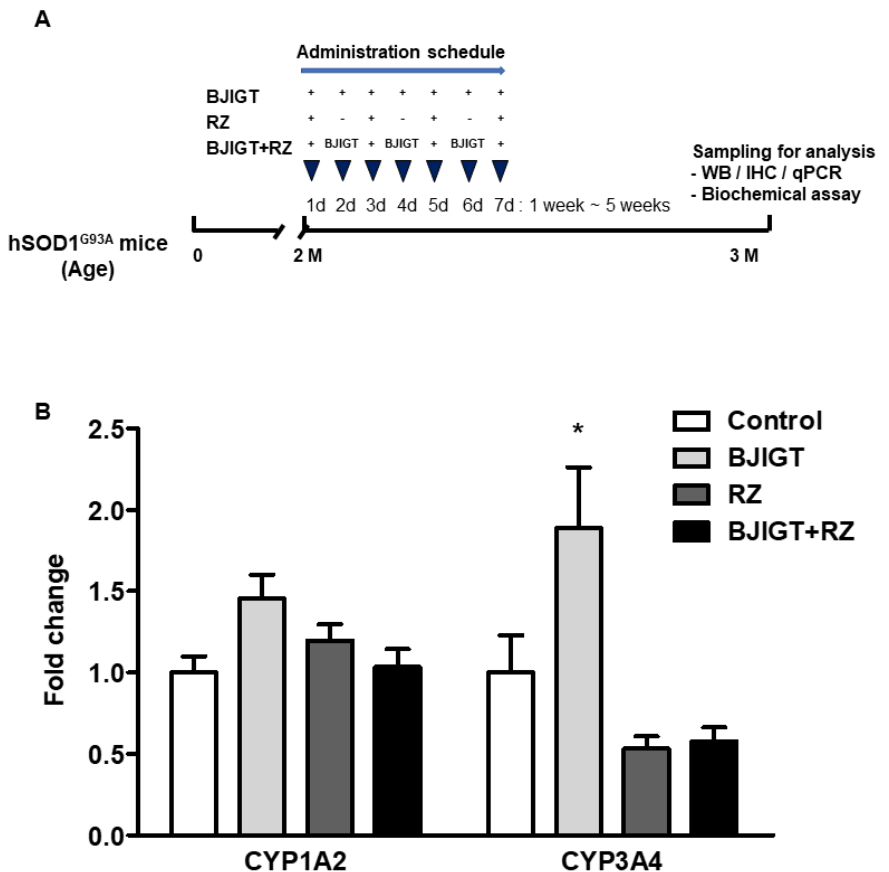
Figure 1. Experimental scheme for the in vivo study and relative expression level of CYP enzymes in the liver of hSOD1 G93A mice. ( A ) In vivo experimental design. Two-month-old hSOD1 G93A mice were administered autoclaved distilled water (control, n = 5 mice), BJIGT (1 mg/g, n = 5 mice), RZ (8 μ g/g, n = 7 mice), or a combination of BJIGT and RZ ( n = 9 mice) for 5 weeks. Mice were sacrificed for analysis 5 weeks after drug administration. ( B ) The expression levels of CYP1A2 and CYP3A4 mRNAs in each group. * p < 0.05 vs. Control. n = 5–9 mice per experimental